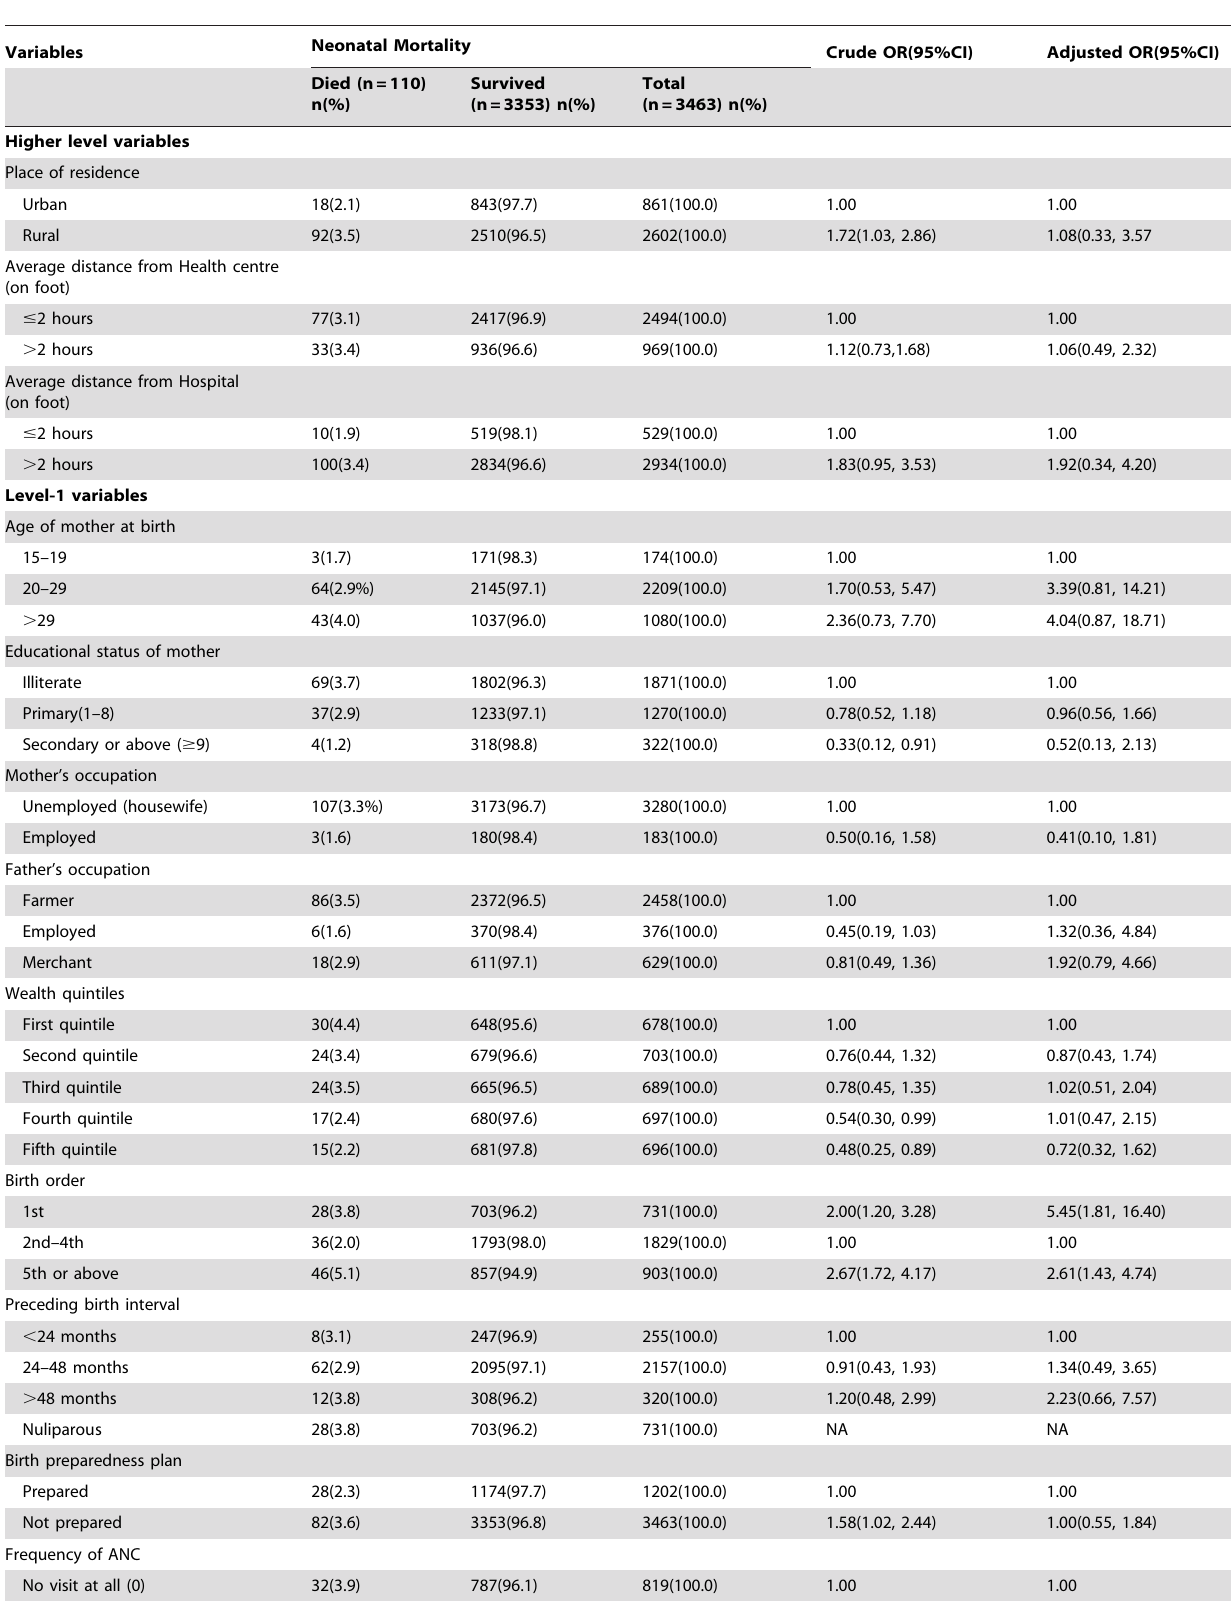
Table 4. Multilevel analysis of factors associated with neonatal mortality, Jimma Zone, Southwest Ethiopia, Sept 2012-Dec